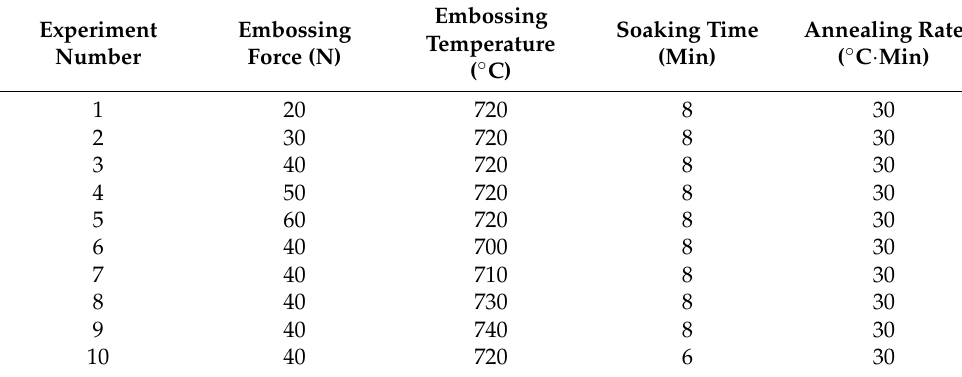
Table 1. Design of the hot embossing